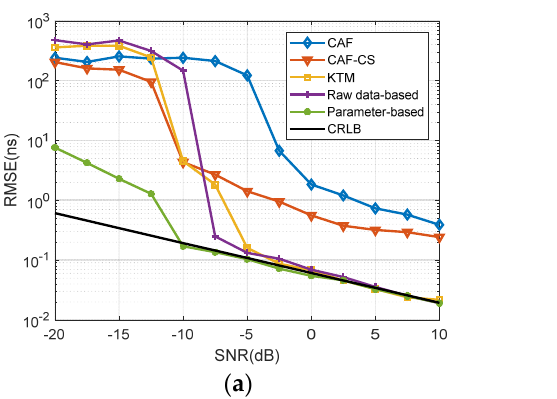
Figure 9. Data transmission in two methods.